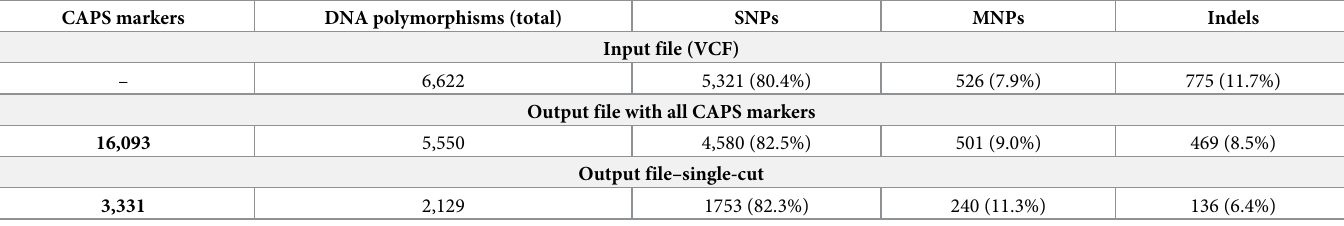
Out of 5,550 CAPS-convertible GBS markers, 1,620 were selected which represented unique sets of genotypes (from groups of ideally co-segregating markers only one was picked up) and were spaced one from another by at least 10 kb (in the reference sequence). From this set of filtered markers, 1,362 and the phenotype (male-sterile vs. male-fertile) were mapped to nine linkage groups/chromosomes (Fig 7). The number of mapped loci ranged from 50 to 231 for chromo- some 7 and chromosome 1, respectively (Table 5). The shortest map length– 31.4 cM–was obtained for chromosome 7, and the longest– 100.8 cM–for chromosome 6. The average Table 4. Statistics of DNA polymorphisms in the VCF2CAPS input and output files generated for population 398. CAPS